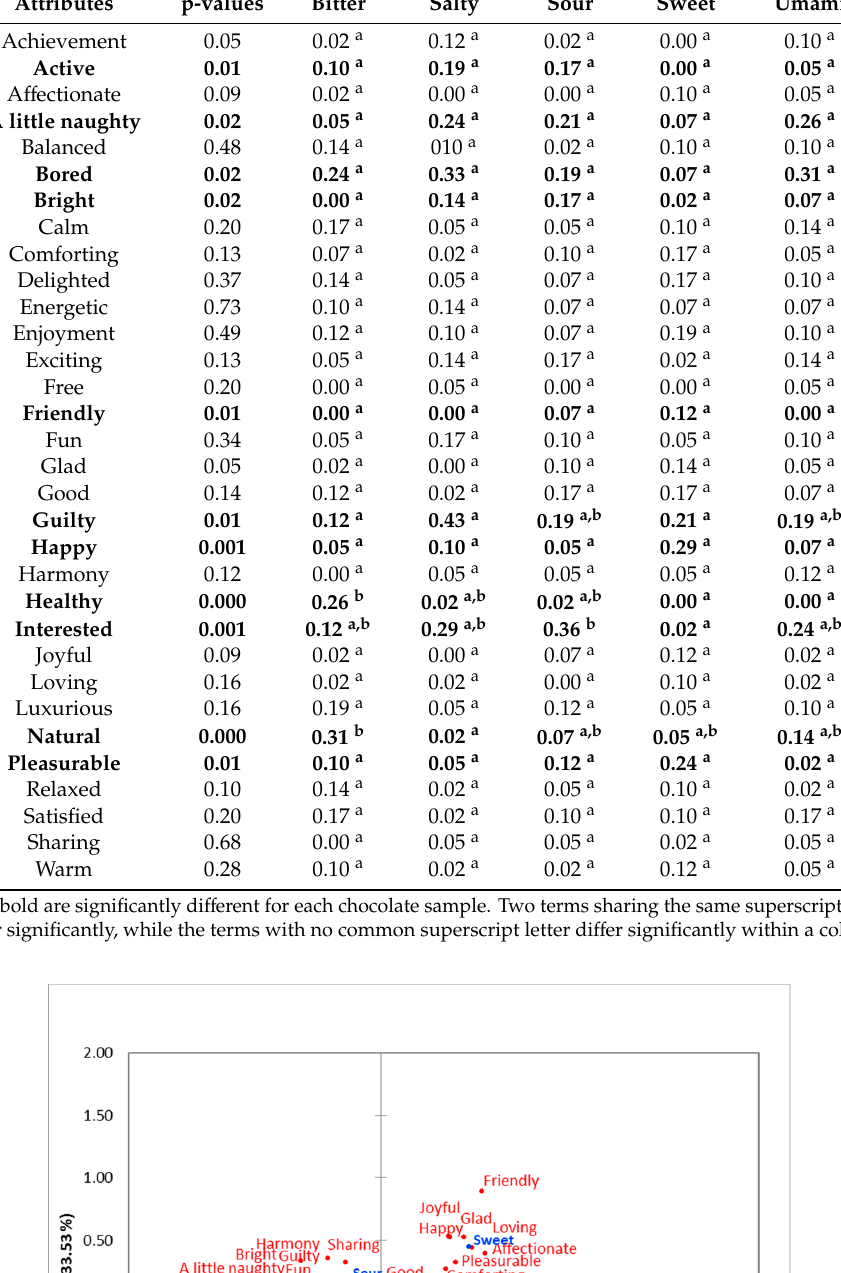
Figure 3. Principal coordinate analysis obtained from the sensory session. 4. Discussion 4.1. Self ‐ Reported Sensory Responses Humans have an innate liking for sweetness [41–43], which is also shown in the results of the present study because the sweet chocolate sample was rated higher in liking by participants. Least overall liking for salty chocolate may be due to the health concerns, such as hypertension, as well as strokes and cardiovascular diseases that can be developed by hypertension usually caused by high salt intake [44]. The bitter chocolate (dark) had the second highest overall liking after the sweet sample, which may be owing to the participants perceptions of the potential health benefits due to the antioxidants available in dark chocolate. This was also seen from the present study because as per the correspondence analysis, dark chocolate was associated with terms such as “healthy” and “natural” in CATA. Previous research has shown that there is a correlation between dark chocolate consumption and reduction of cardiovascular diseases by acting against low ‐ density lipoprotein oxidation and free radicals [45–49]. Consumers also responded to compounds that give bitterness